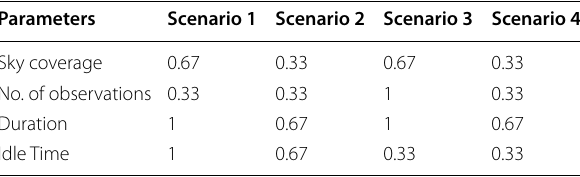
Table 1 Weight factors used for different reference networks: “scenarios” as of Fig.